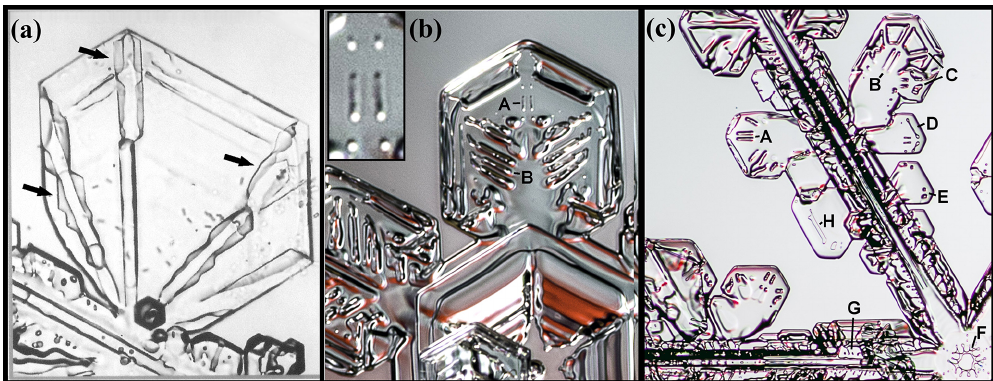
Figure B13. Protruding growth on branch backsides and branch pockets. (a) Sidebranch of dendrite. Arrows show protrusion features on ridges. (b) Branch of broad-branch crystal. Inset is close-up of main ridge pockets A on one branch; B marks side-ridge pockets. (c) Branch of dendrite. Sublimation has apparently exposed several pocket features (A–H) described in text. Image in (a) from large hoar crystal grown in an unforced air-flow cloud chamber of Yamashita and Ohno (1984). Crystals in (b) and (c) from snow crystals collected at ground level (courtesy of Mark Cassino).